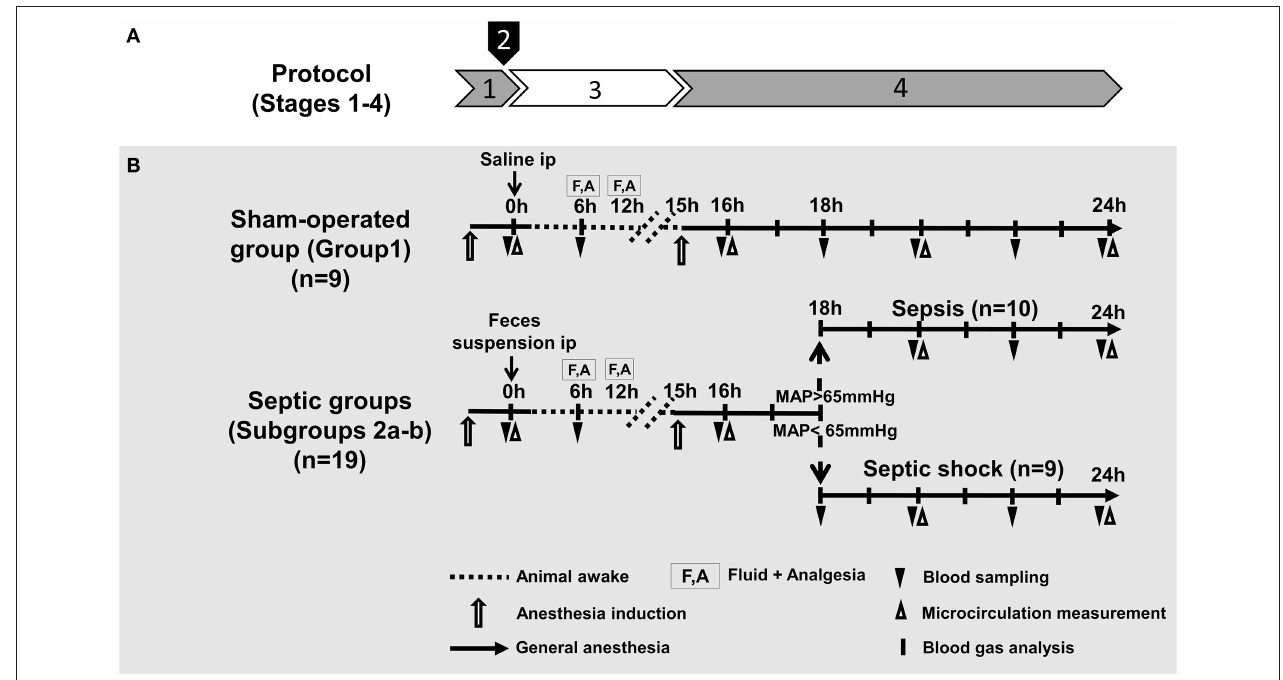
FIGURE 1 | Experimental stages (A) , experimental protocol, groups, interventions and assessments (B) . (A) Experimental stages: (1) baseline measurements (under temporary anesthesia); (2) sepsis induction with intraperitoneal (ip) fecal inoculum; (3) sepsis progression (in awake animals); and (4) re-anesthesia, instrumentation, monitoring and scoring (B) . Groups: The animals were randomly assigned into sham-operated and septic groups. Based on disease severity and vasopressor requirement (at 18h after sepsis induction), animals in the septic group were allocated into sepsis and septic shock